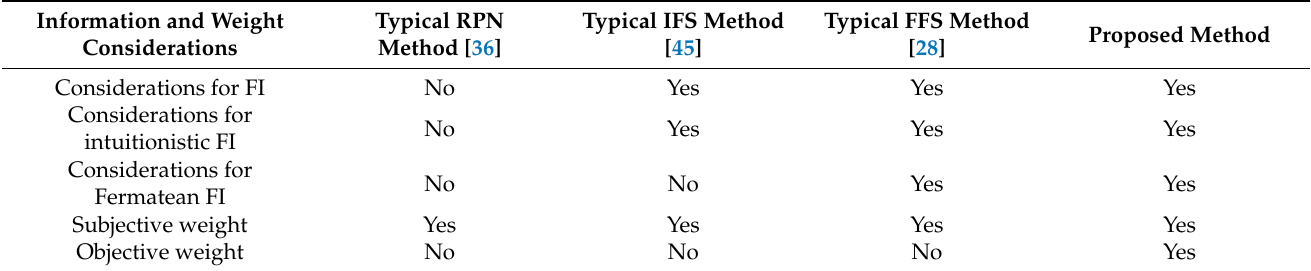
Table 12. The main differences in information and weight considerations for different calculation